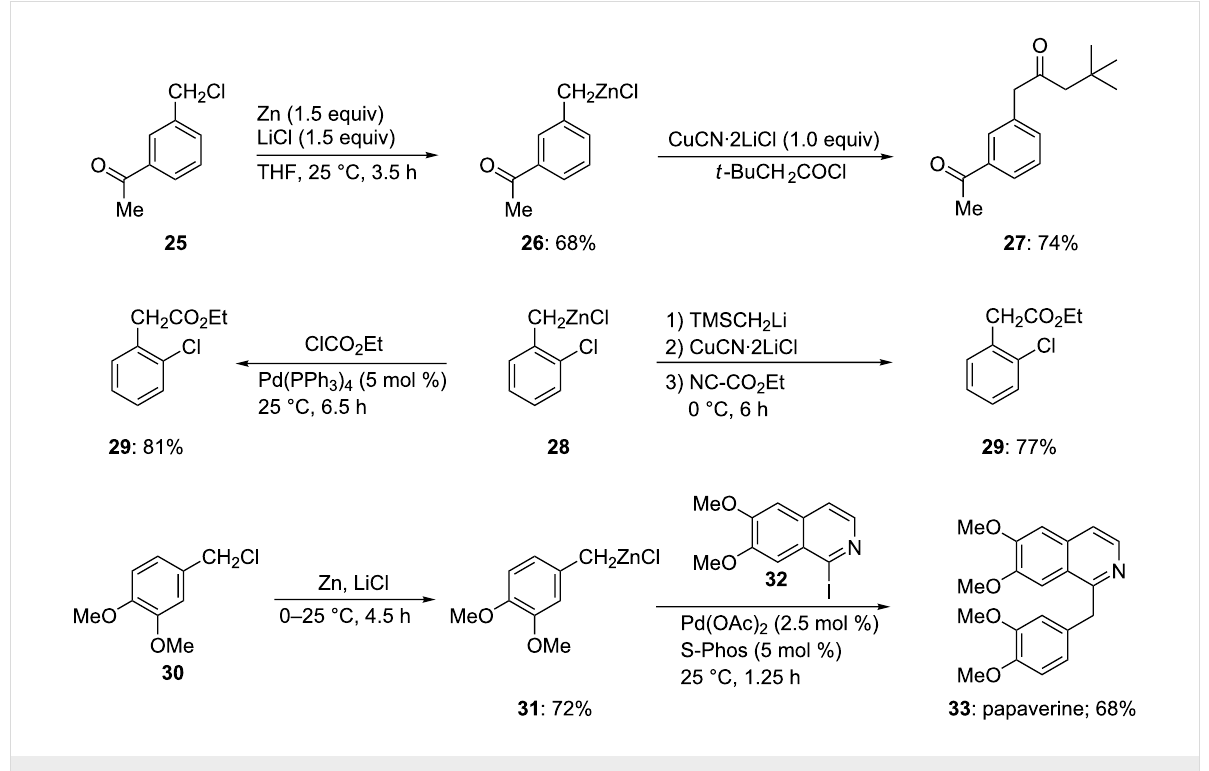
Scheme 5: Preparation and reactions of benzylic zinc